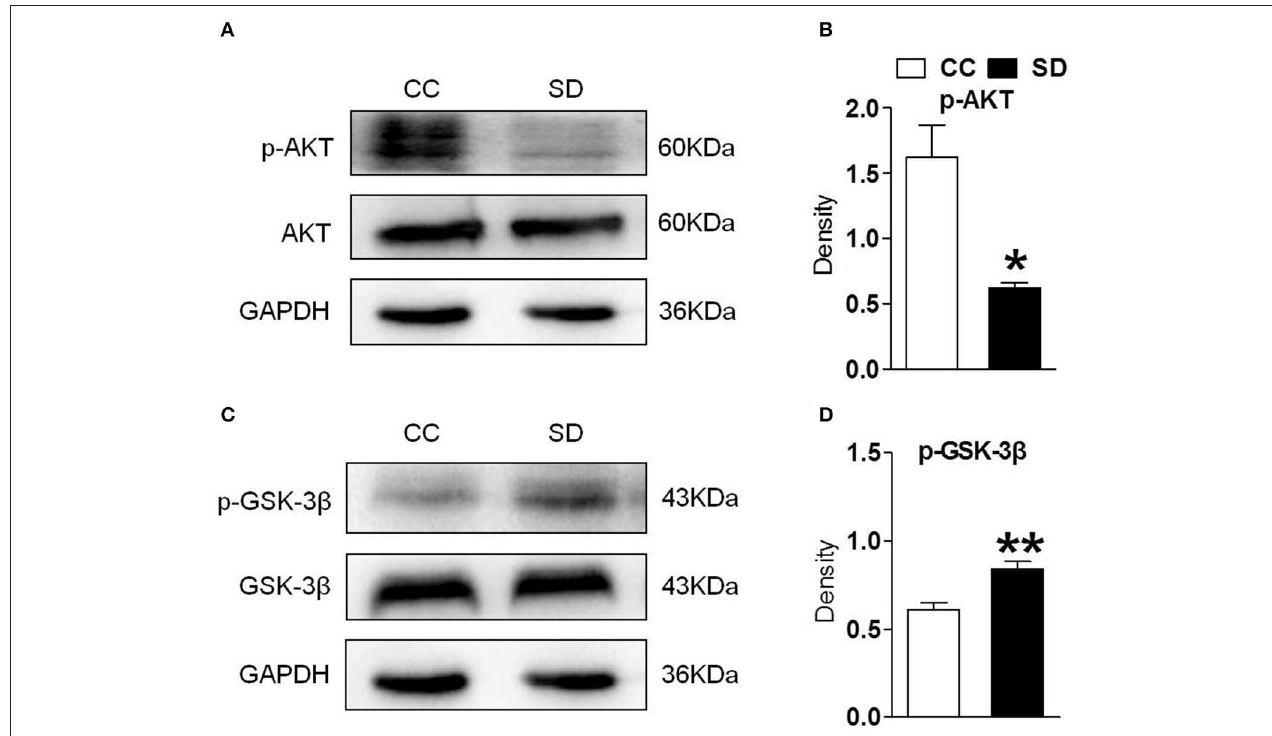
FIGURE 2 | Hippocampus PI3K/AKT/GSK-3 β was suppressed after chronic sleep deprivation. Western blot was used to examined the protein p-AKT, AKT, p-GSK-3 β , GSK-3 β . (A,B) Chronic sleep deprivation for 7 days significantly decreased expression of p-AKT in hippocampus. (C,D) Chronic sleep deprivation for 7 days increased the expression of p-GSK-3 β in hippocampus. The results are expressed as mean ± SEM,* P < 0.05, ** P < 0.01, vs. control group.